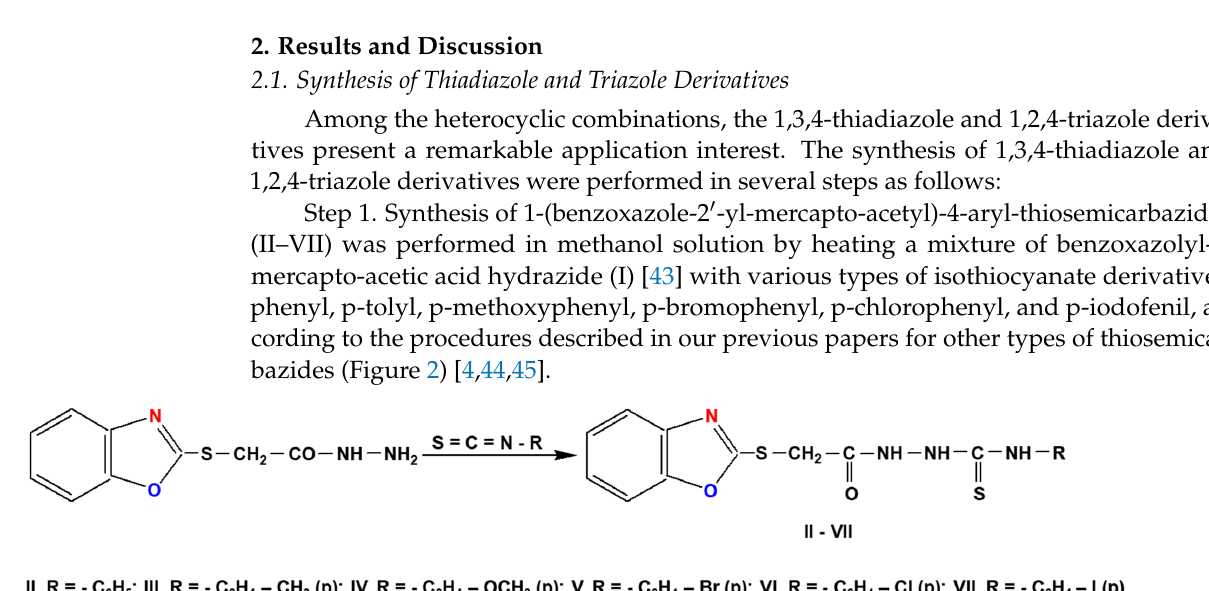
Figure 2. Synthesis of 1-(benzoxazole-2 ′ -yl-mercapto-acetyl)-4-aryl-thiosemicarbazides (II-VII).